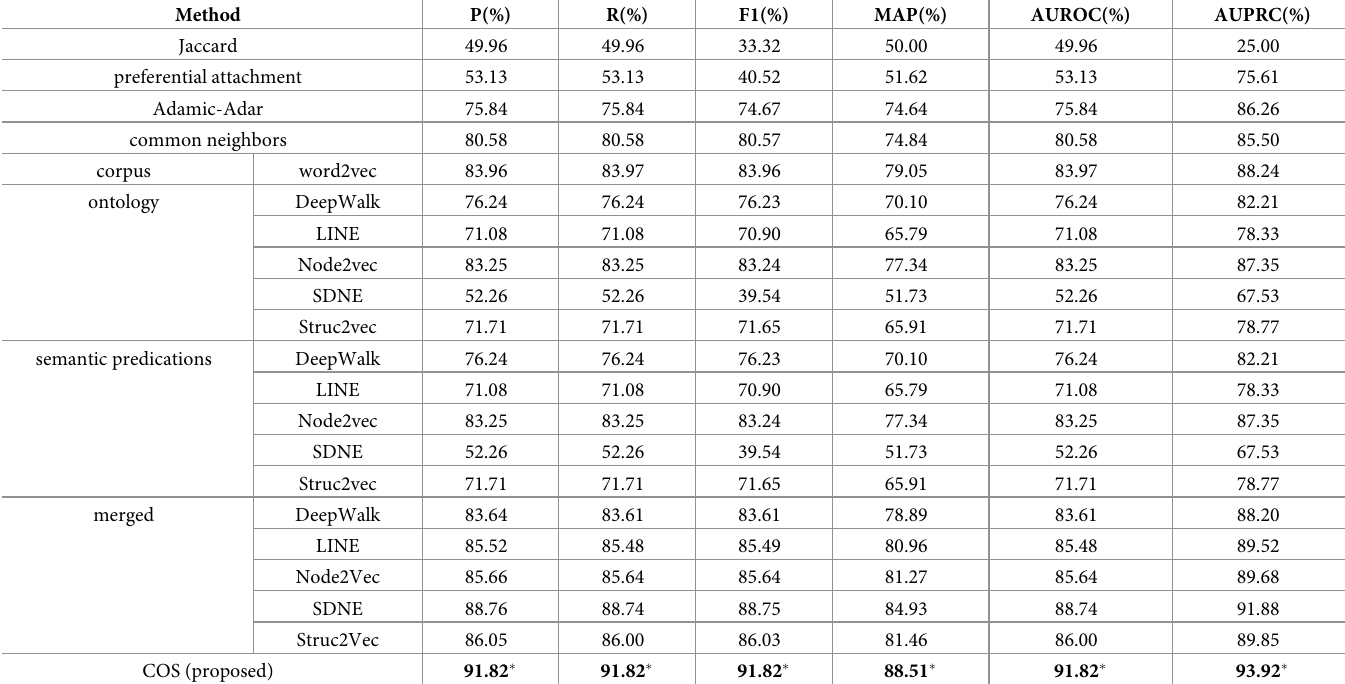
Table 7. Edge prediction results for affect.